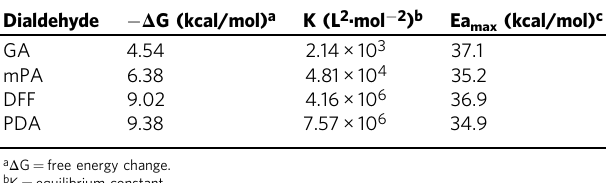
Table 1 Calculated parameters for the formation of bis- Schiff